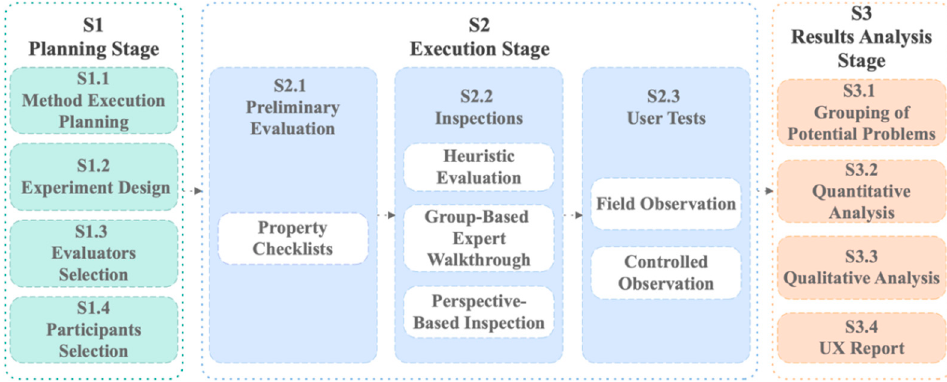
Figure 2. Stages of the UX evaluation methodology for people with ASD.